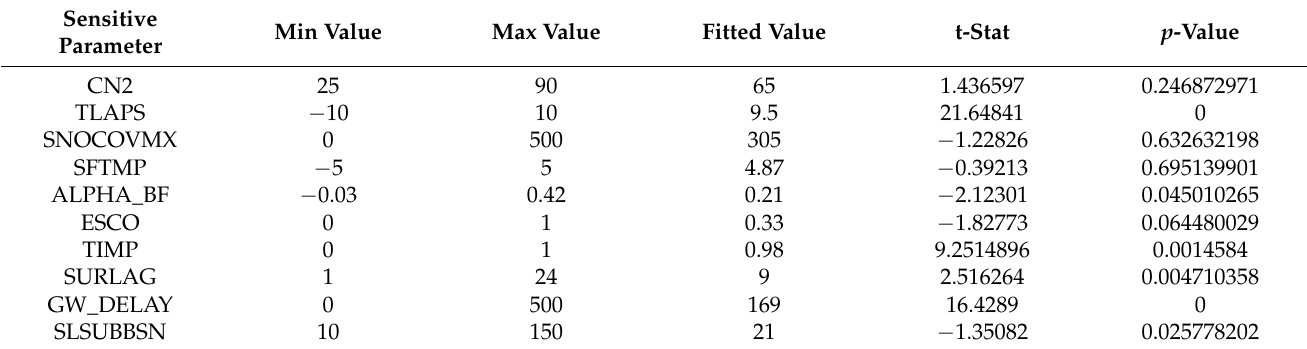
Table 2. Streamflow-sensitive parameters in the study area.